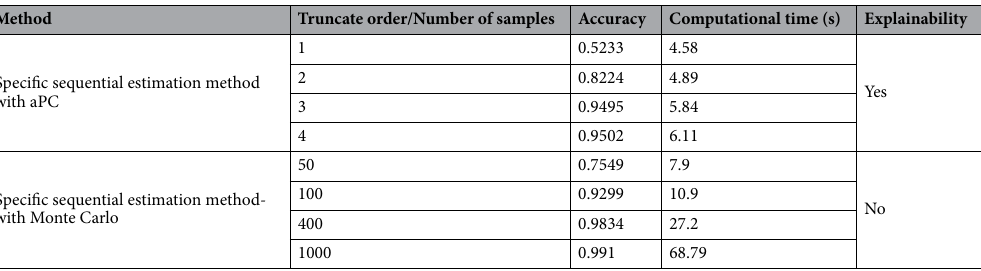
Table 2. Methods to estimate node-level